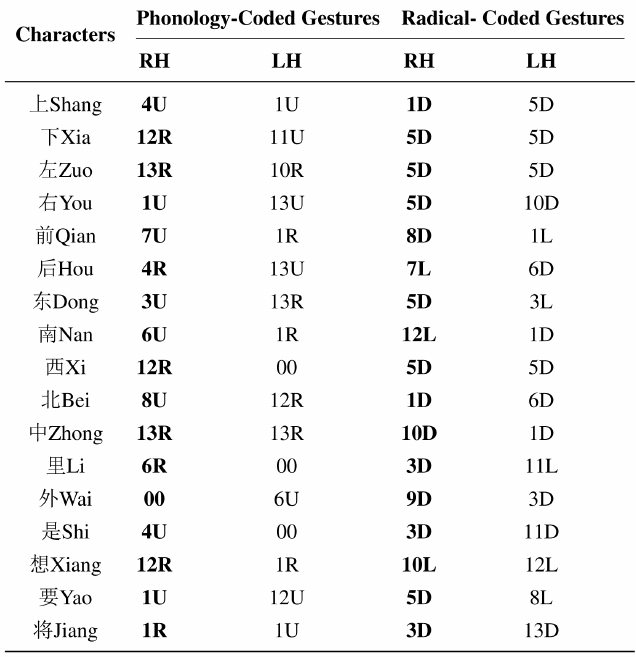
Figure 11. Typical Chinese characters with corresponding coded